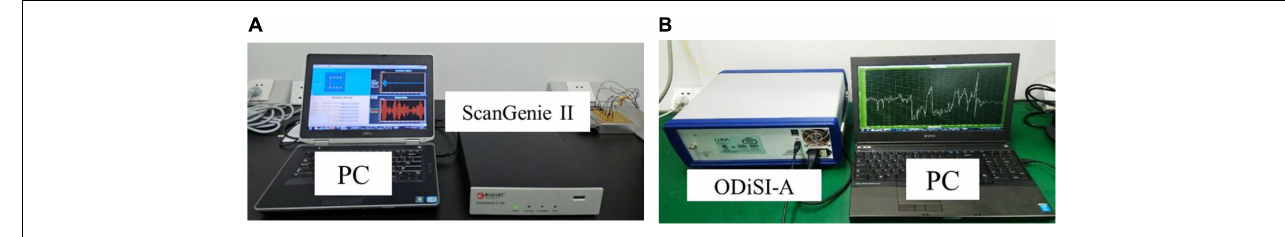
FIGURE 6 | Experimental monitoring system for measuring signals of optical fibers and guided waves: (A) ScanGenie II, (B) ODiSI.